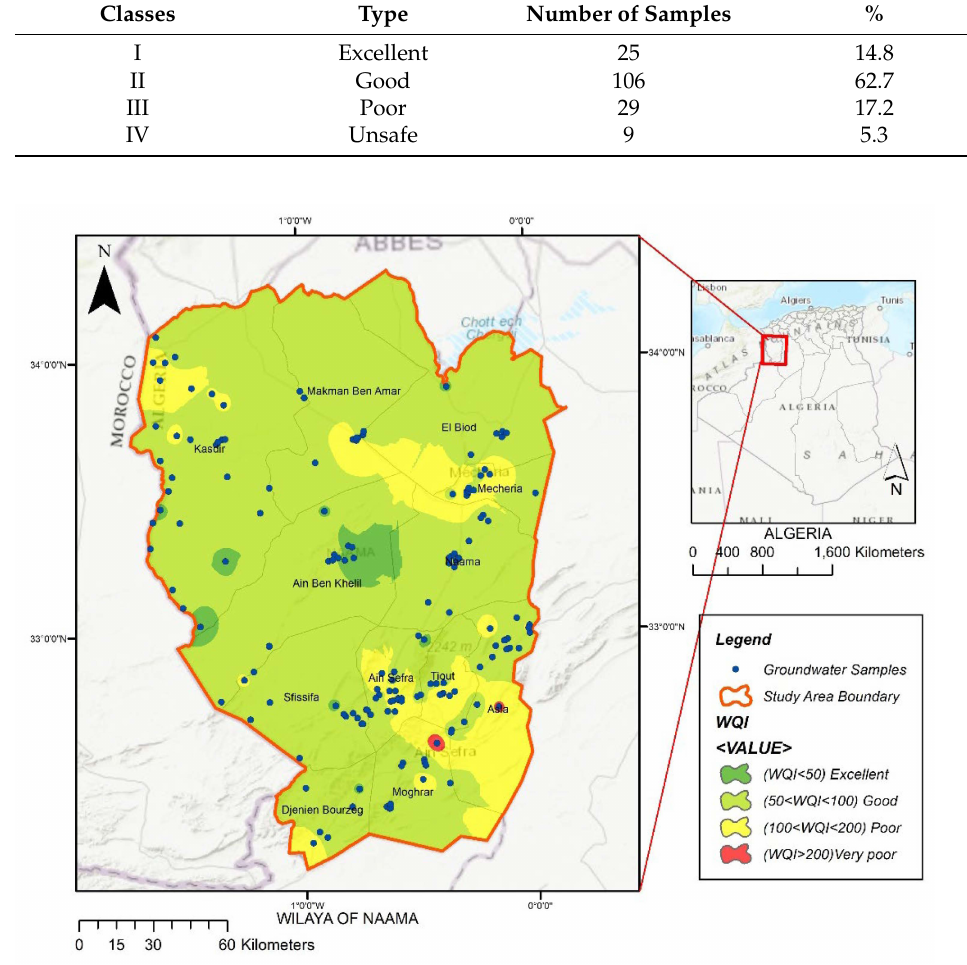
Figure 3. Spatial distribution of WQI in the study